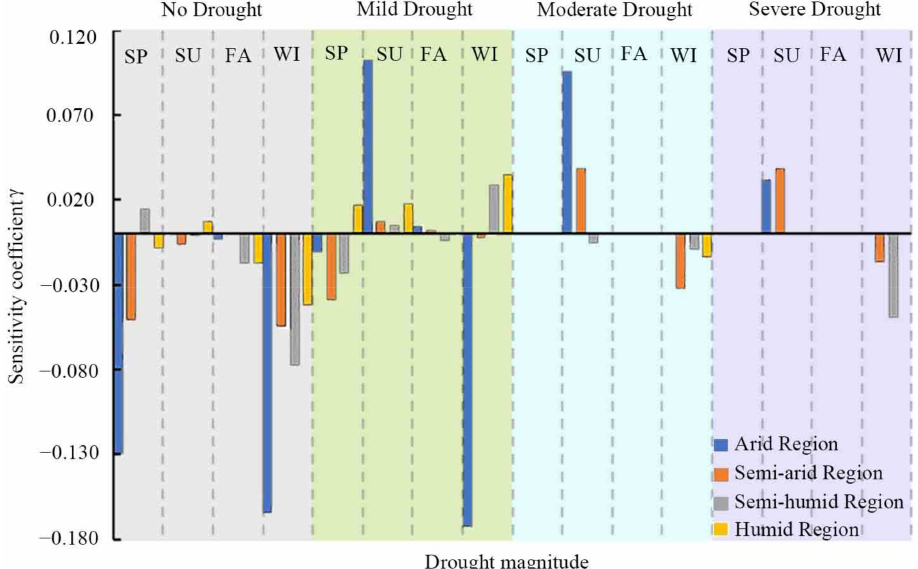
Figure 6. Water-use efficiency (WUE) sensitivity coefficients in response to seasonal drought in climates regions. Note: SP: spring; SU: summer; FA: fall; WI: